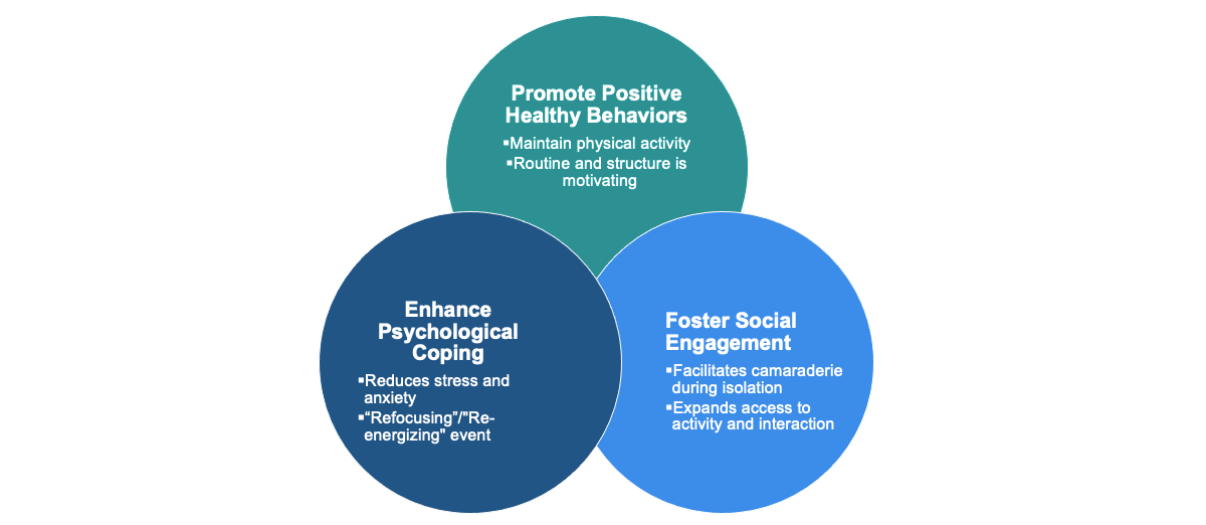
Figure 1. Behavioral-Psychological-Social Coping model of how virtual mind-body programs can support the psychosocial well-being of cancer patients.